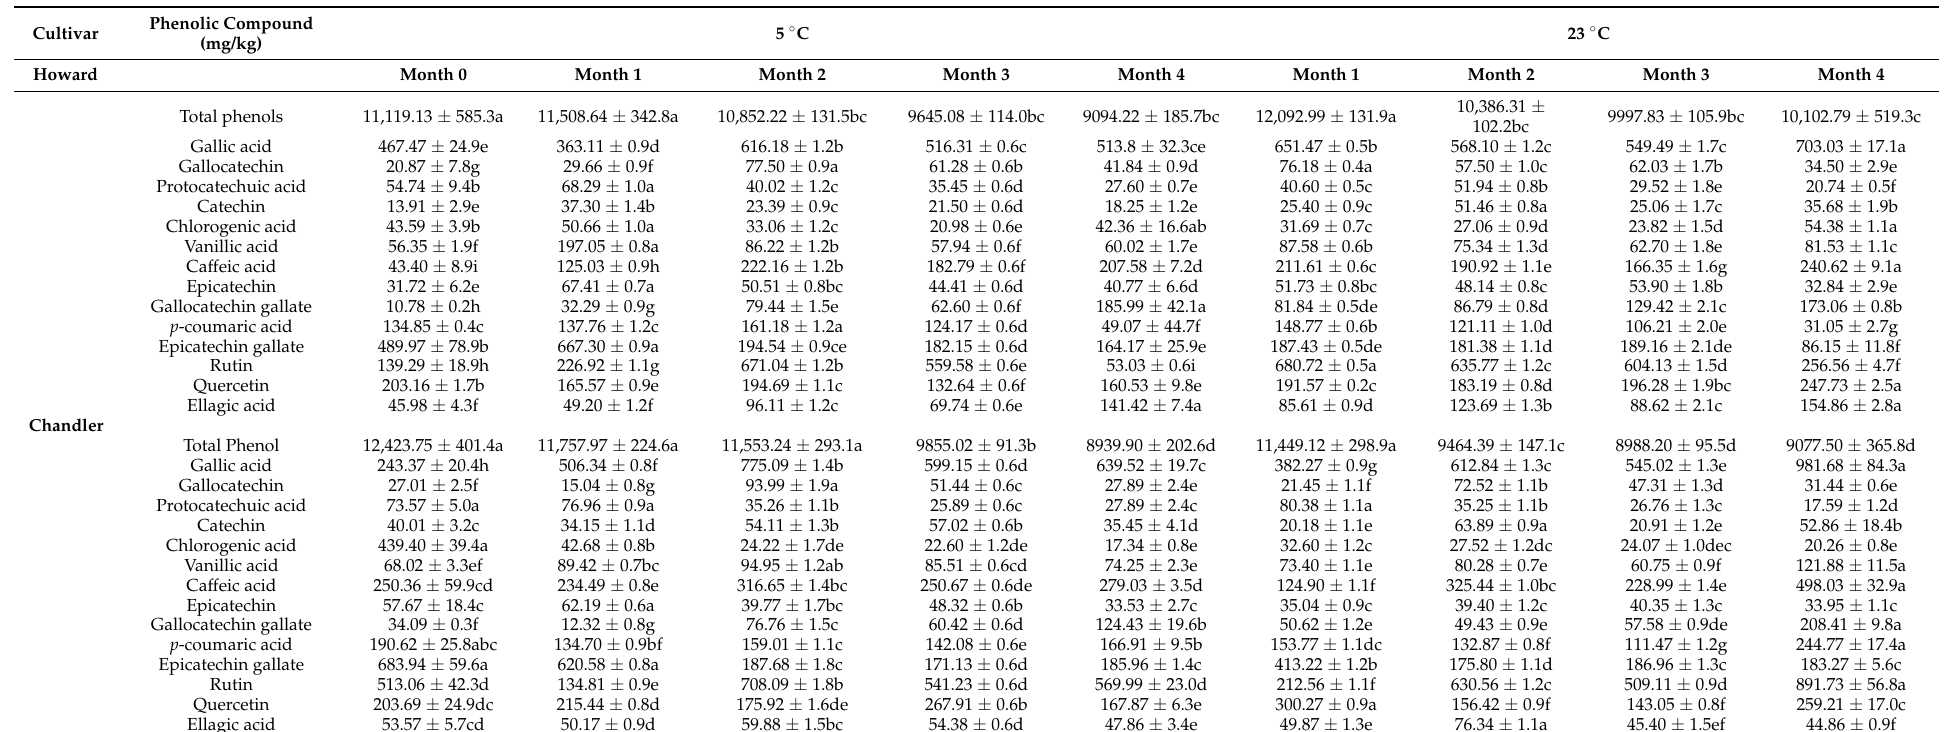
Table 2. Changes in phenolic composition of walnut kernels during